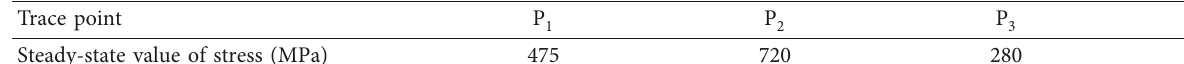
Figure 10: The residual stresses at the trace points at different times (2 nd welding condition): (a) 0–1s; (b) 1–10 s; (c) 10–200s. Table 7: Steady-state residual stresses at the trace points.